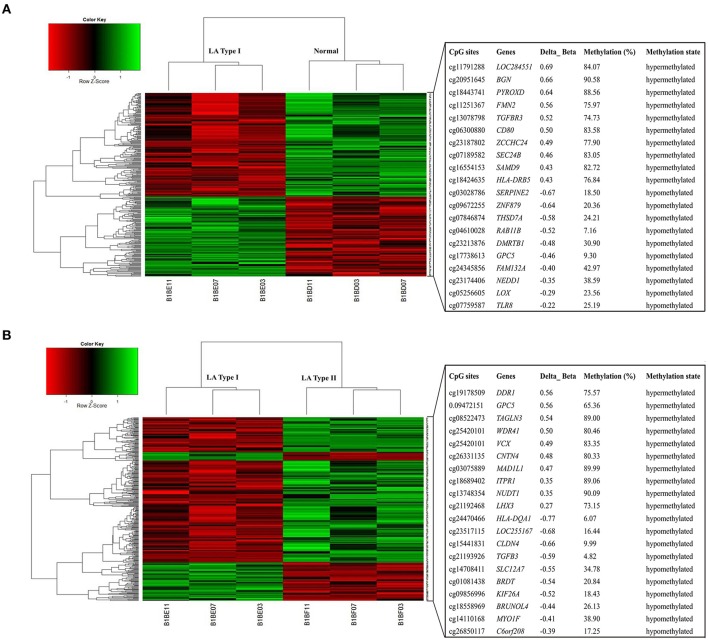
Heatmap of differentially methylated genes in both LA occurrence and progression. The top and low heatmaps demonstrated supervised hierarchical clustering of hypermethylated and hypomethylated genes in the occurrence (LA type I vs. Normal) (A) and in progression (LA type II vs. type I) (B), respectively. The green/red color represented a standardized level of DNA methylation both in LA type I (vs. Normal) and in LA type II (vs. LA type I). The list of clustered genes is selectively represented in the right panels. The top and low panels showed the hypermethylated genes and hypomethylated genes in the occurrence (A) and progression (B) and its methylation level in LA type I (A) and LA type II (B) respectively.